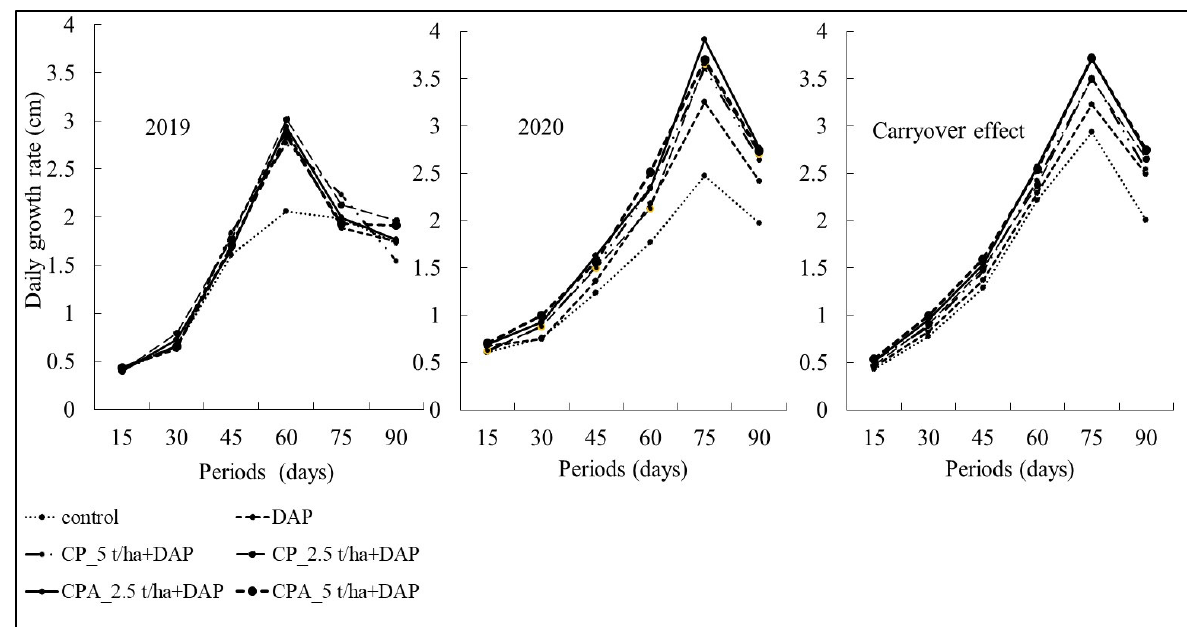
Figure 2. Growth rate for sorghum plant per treatment.